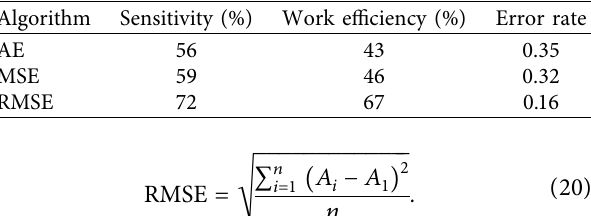
Table 2: Population growth rate and vehicle growth rate,